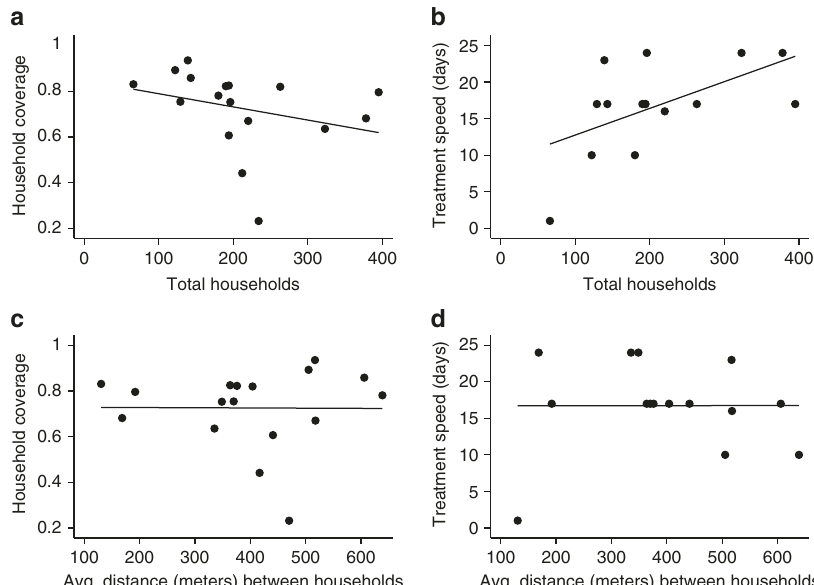
Fig. 4 Village size and accessibility against treatment outcomes. Household coverage is de fi ned as the proportion of households in the village where at least one eligible person in the home was offered at least one treatment through mass drug administration. Treatment speed is de fi ned as the number of days until community medicine distributors visited 50% of households. Within the one-month distribution period, 15/17 villages achieved 50% household coverage. Supplementary Table 14 presents the regression results and signi fi cance of the relationships shown in Fig. 4. a , b The village size, as measured by the total households in the village, was not signi fi cantly related to household coverage ( p value = 0.077) and borderline insigni fi cant for treatment speed ( p value = 0.054). c , d The average distance between any two households in each village was calculated in meters. There was no correlation ( p value > 0.05) with household coverage or treatment speed and the average distance between